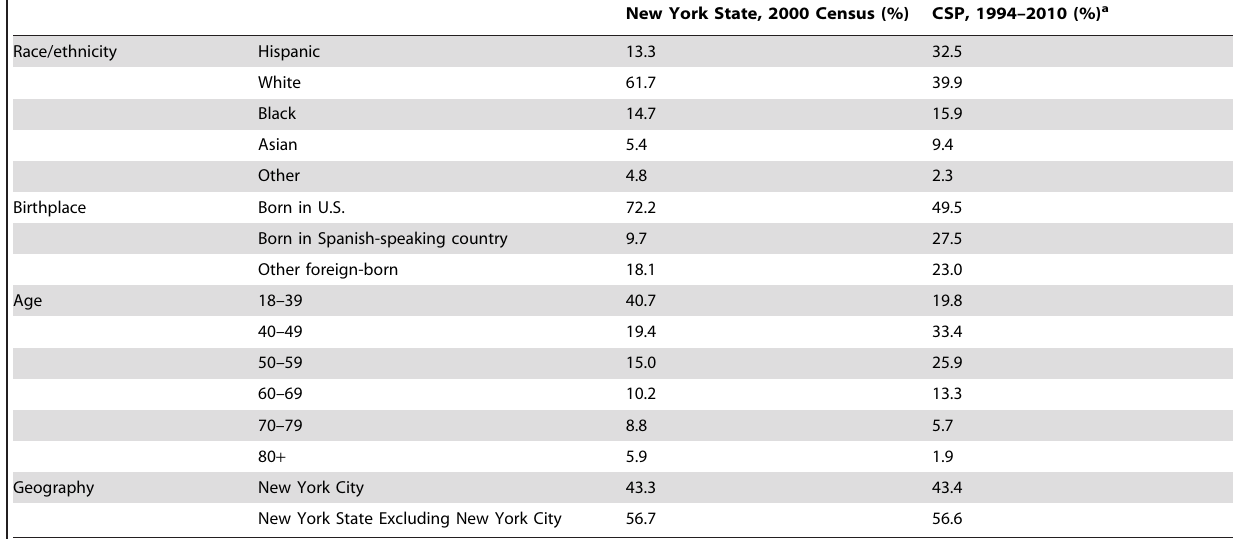
Table 2. Comparison of New York State and CSP populations, age 18 and above.